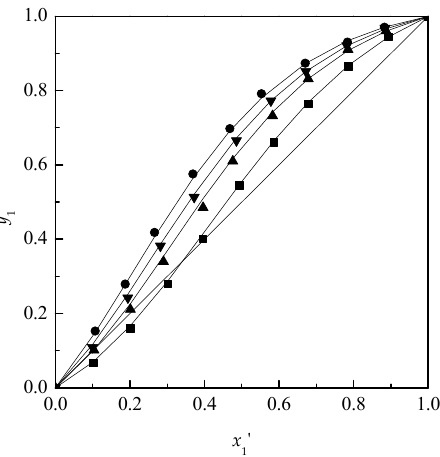
Figure 2. Isobaric VLE diagram for the system of acetone (1) + chloroform (2) + [MMIM][DMP] (3) at 101.3 kPa: ■ , x 3 = 0; ▲ , x 3 = 0.10; ▼ , x 3 = 0.15; ● , x 3 = 0.20; solid line, calculated using NRTL model.